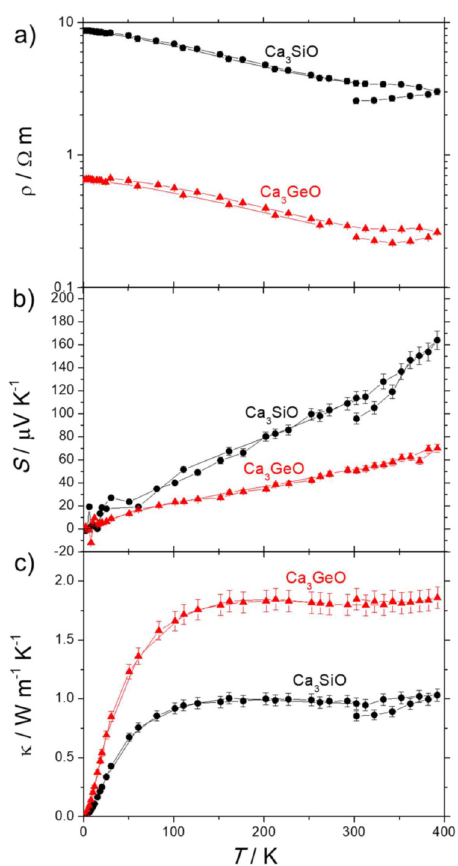
Figure 8. Computed Seebeck coefficients for ( a ) Mg 3 SiO, ( b ) Mg 3 GeO, ( c ) Ca 3 SiO, and ( d ) Ca 3 GeO assuming p-type (solid symbols) or n-type carriers (open symbols). Reproduced from [100], © 2019, the authors.